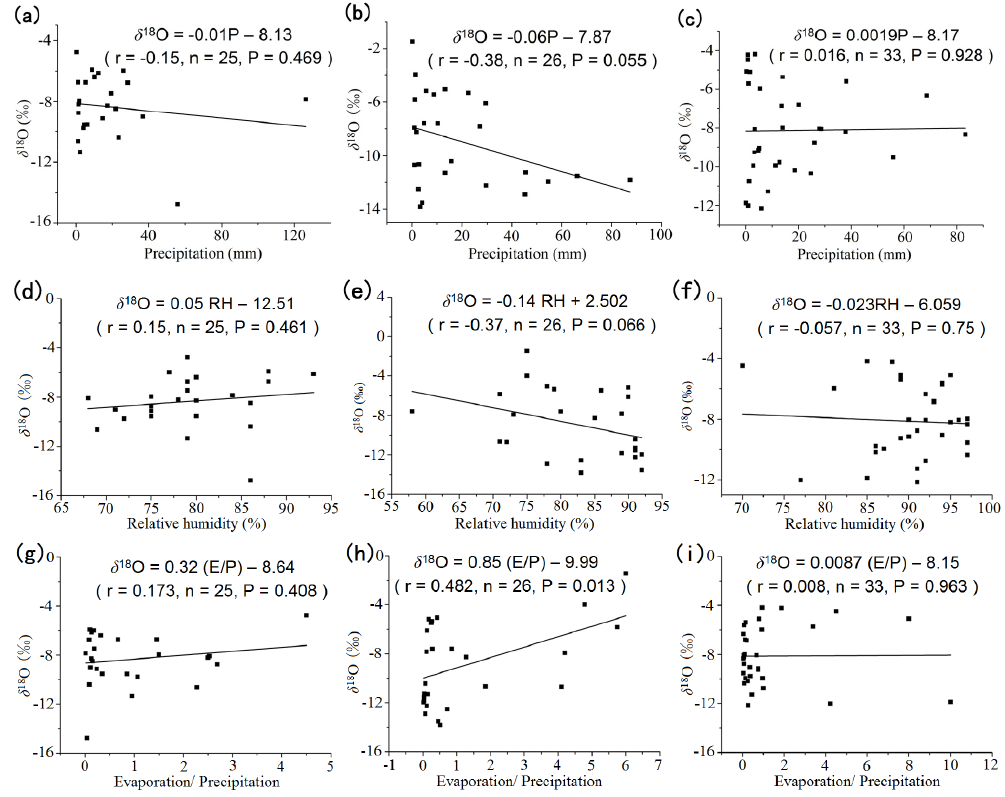
Figure 5. This figure shows (1) correlation between δ 18 O and precipitation amount in Nanjing from June to September for 2012 (a) , 2013 (b) and 2014 (c) ; (2) correlation between δ 18 O and relative humidity in Nanjing from June to September for 2012 (d) , 2013 (e) and 2014 (f) ; (3) correlation between δ 18 O and evaporation/precipitation (E / P) ratio in Nanjing from June to September for 2012 (g) , 2013 (h) and 2014 (i) . Linear regression lines, correlation coefficient r and p values are also shown.